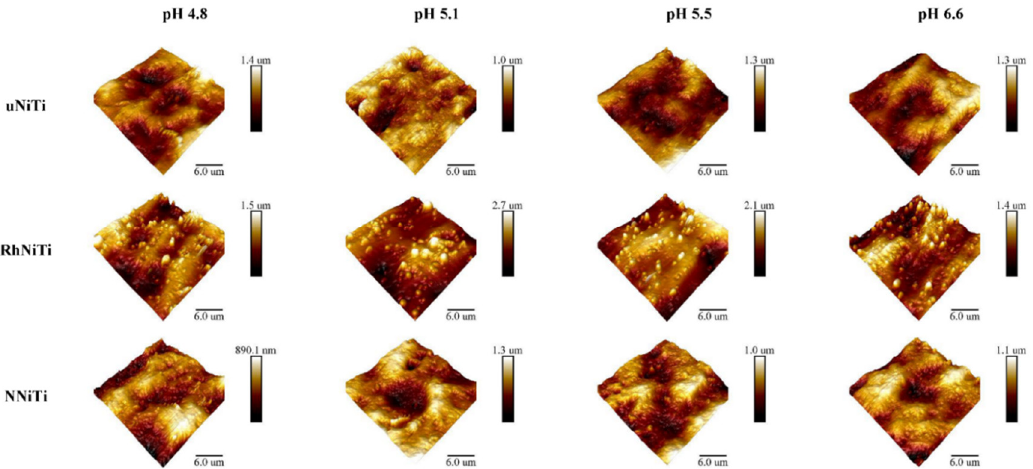
Figure 2. Typical AFM findings from every experimental group (horizontal rows: uncoated NiTi (uNiTi), rhodium-coated NiTi (RhNiTi), and nitrified NiTi (NNiTi) wires), after immersion in artificial saliva with four different pH values (vertical columns), presented as a three-dimensional chart.